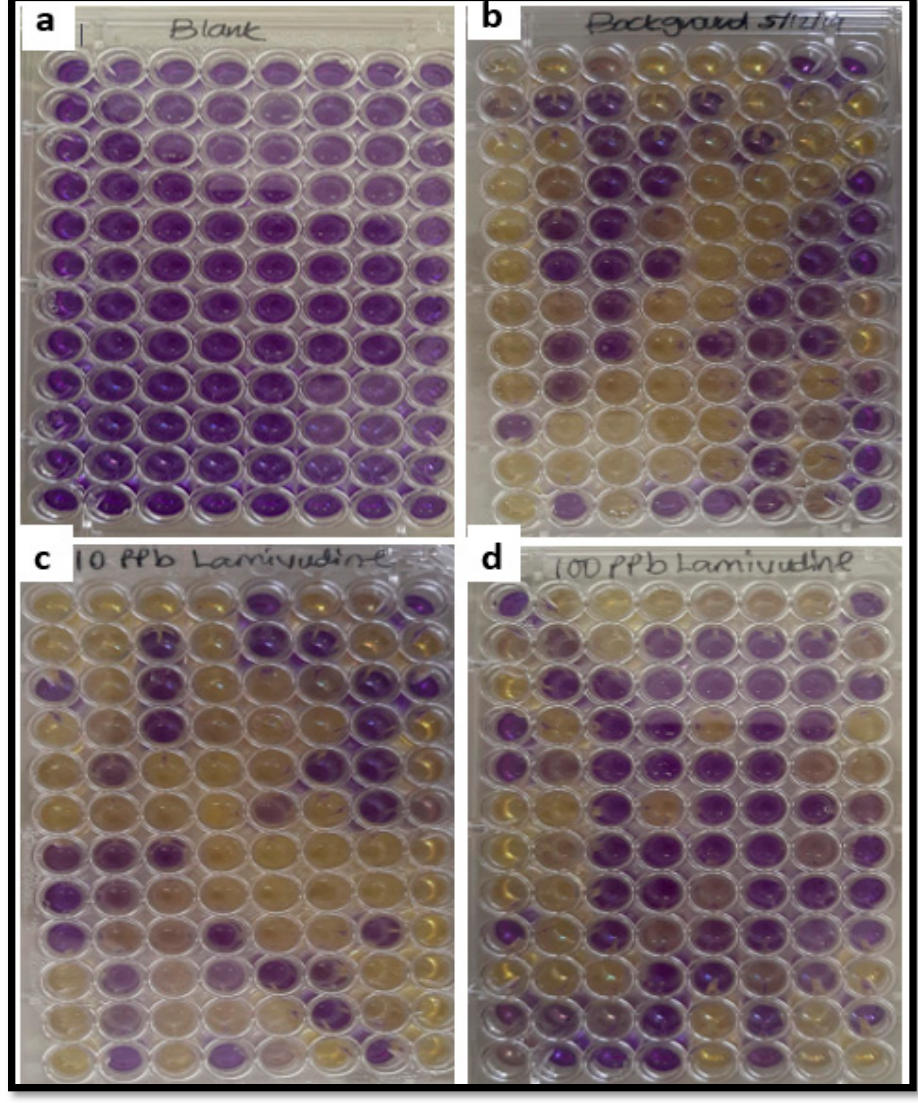
Figure 2. Ames mutagenicity test (EPBI TM ) using TA 100 S. typhimurium bacterial strain: exposure to